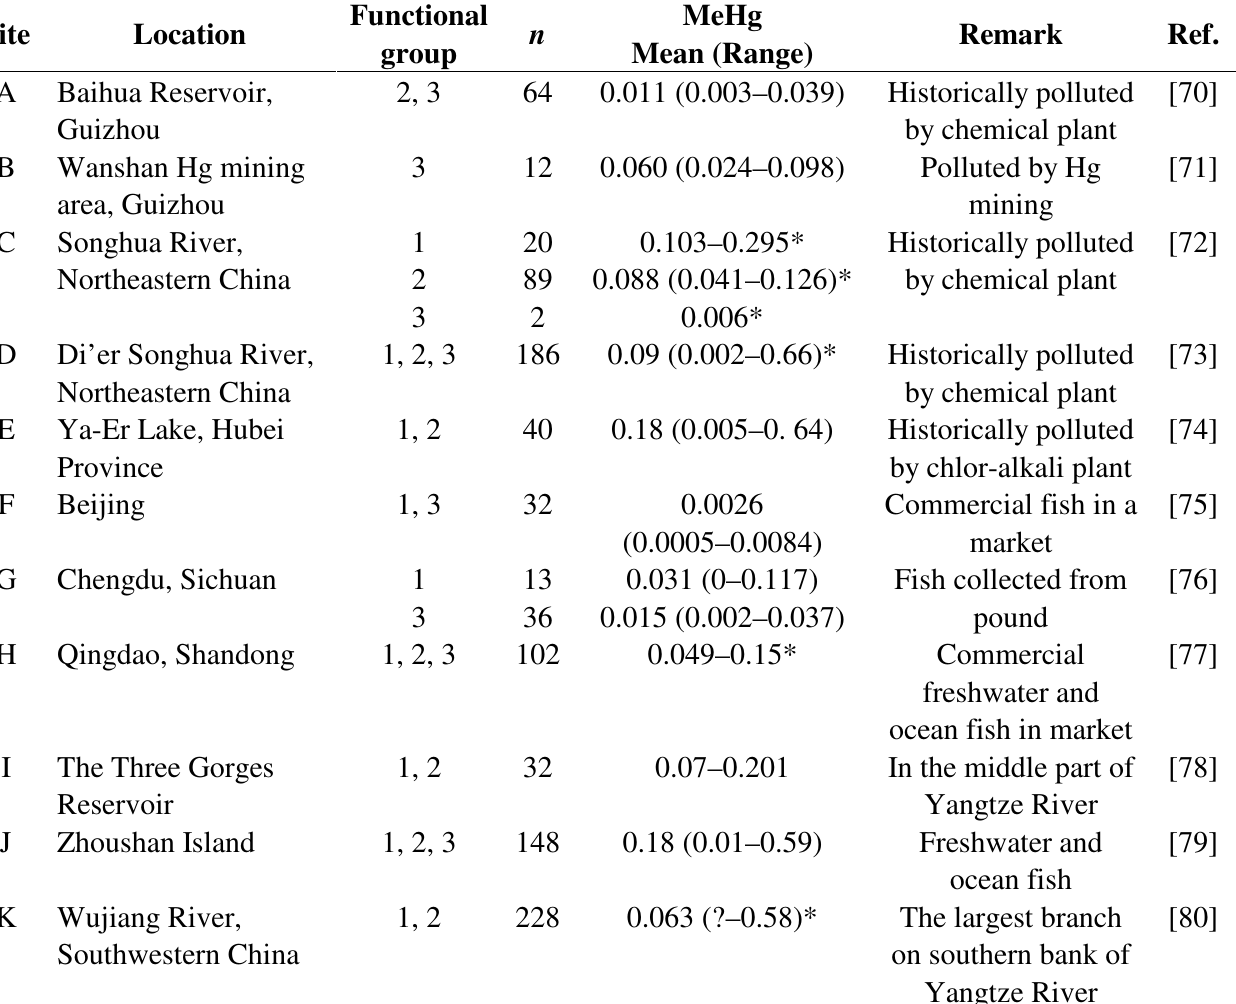
Table 2. The comparison of MeHg level in fish from different sites of China/µg·g −1